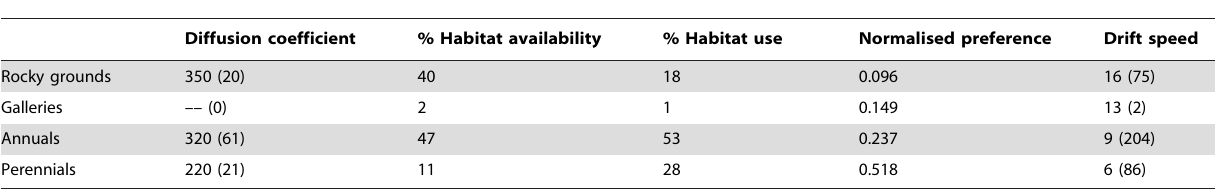
Table 1. Habitat-specific diffusion coefficients, preferences and drift